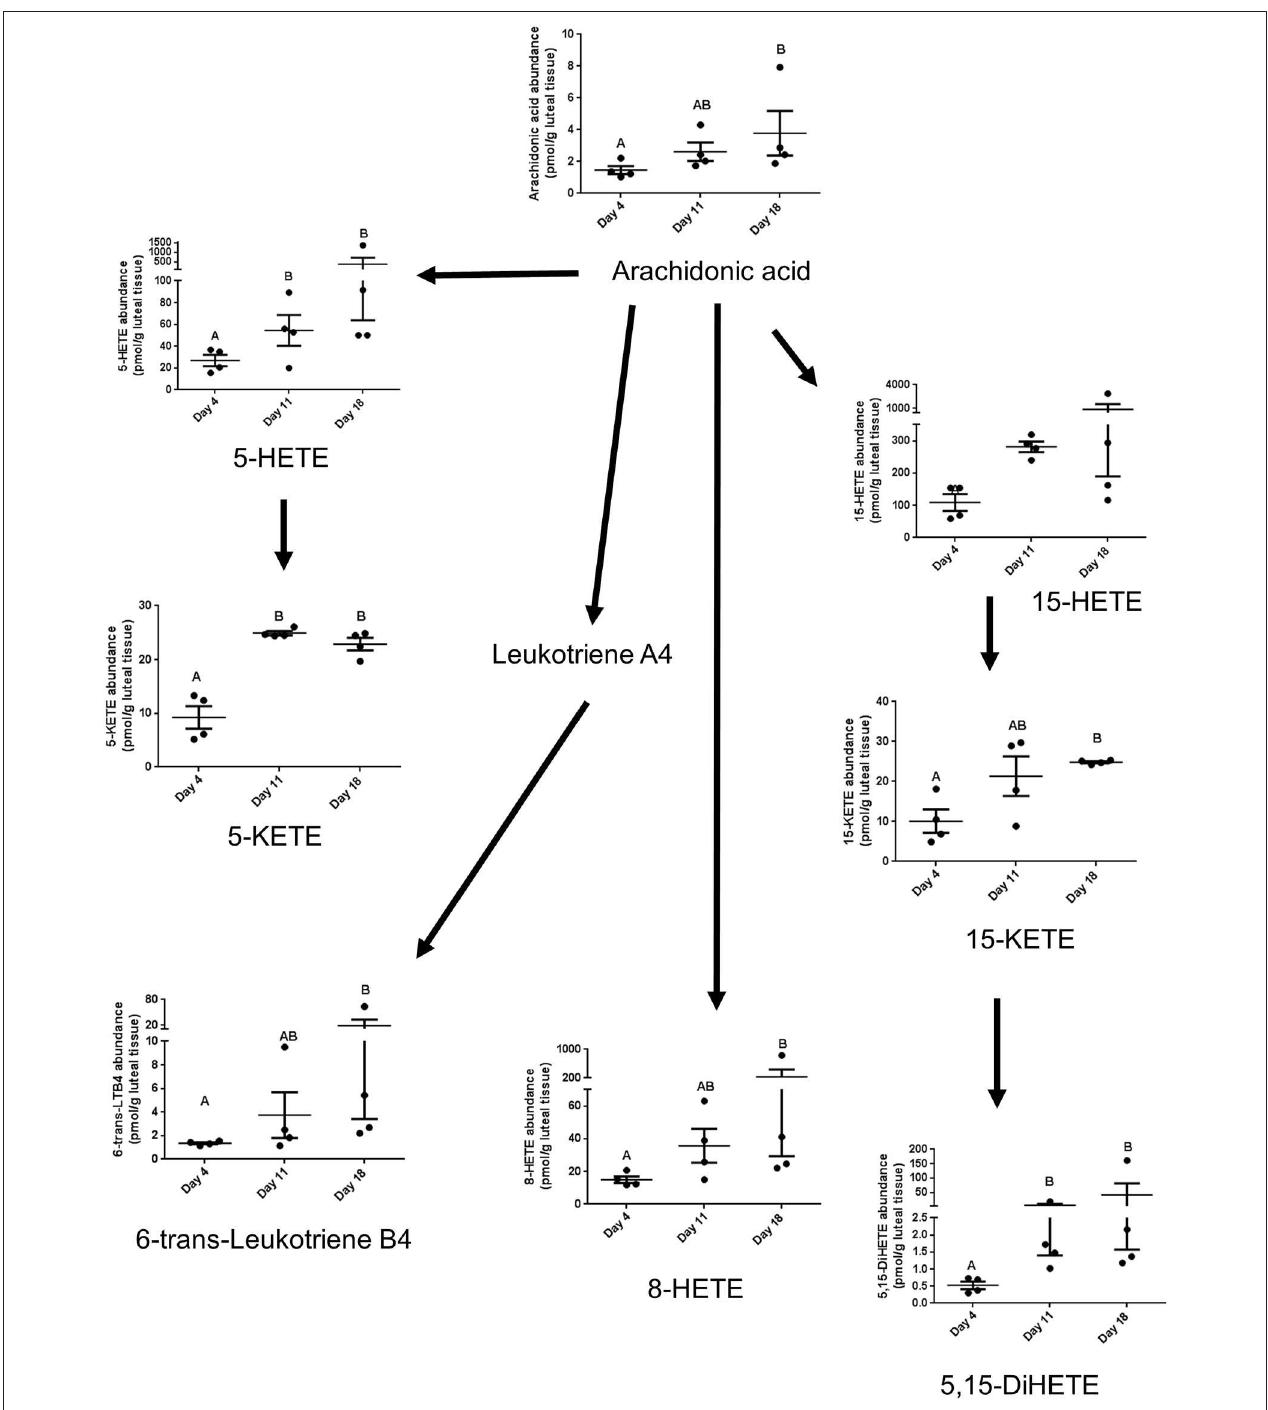
FIGURE 3 | The lipids that are components of the lipoxygenase pathway that were measured in this study, with arrows indicating synthesis relationships between lipids. 6-trans-LTB4 is also a reported decomposition product of the 5-lipoxygenase derived leukotriene C4.